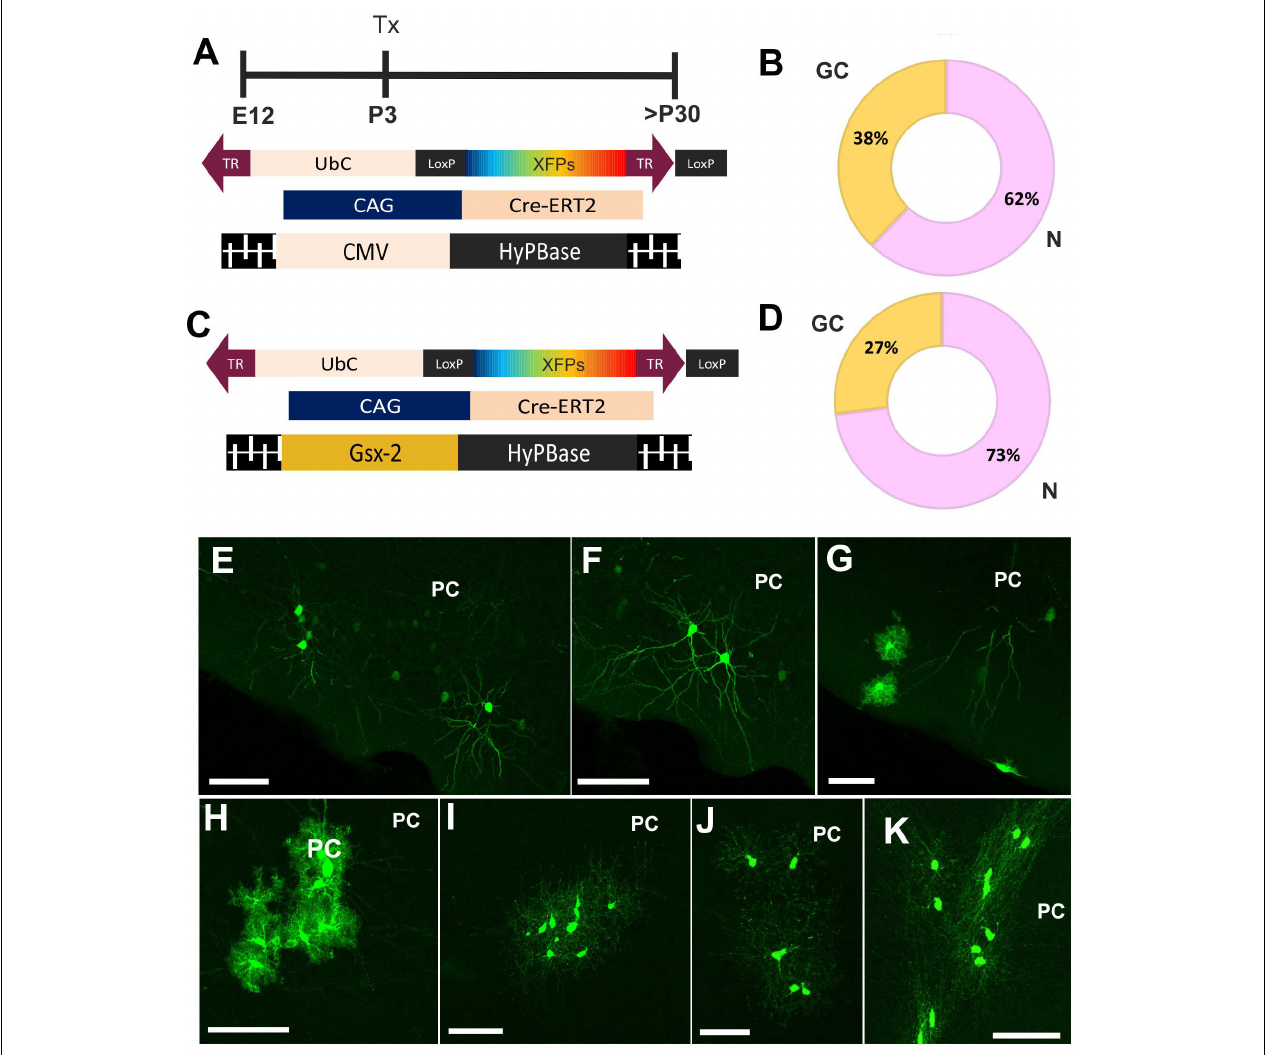
FIGURE 2 | Cell fate of ventral progenitors in adult piriform cortex. (A) Scheme of the UbC-StarTrack approach using the CMV transposase. (B) The proportion of neurons (pink) was 62% whereas in glial cells (yellow) the proportion was 38%. (C) Gsx2-trasnposase was used to target ventral E12 progenitor cells and their cell progeny was analyzed in adult stages. (D) The proportion of their derived-cell progeny was similar to panel (B) . (E,F) Labeled neurons are located in LII-LIII, as well as the glial cell profiles (G) . (H) Astrocytes with stellate morphology located along the different PC layers. (I,J) NG2 cells in the PC. (K) OL cells labeled in the PC. N, neurons; GC, glial cells, OL, oligodendrocytes; IUE, in utero electroporation; LOT, lateral olfactory track; PC, piriform cortex; Tx, tamoxifen. Scale bar: 50 µ